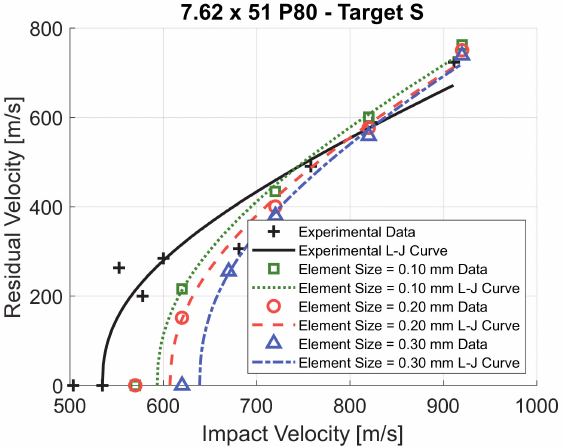
Figure 7. Mesh convergence analysis for the element size of the plate (target